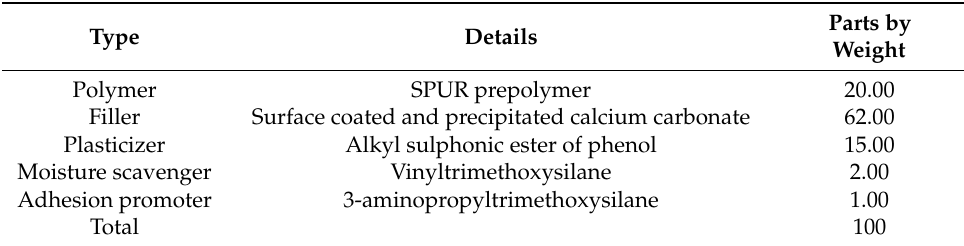
Table 3. The composition of SPUR